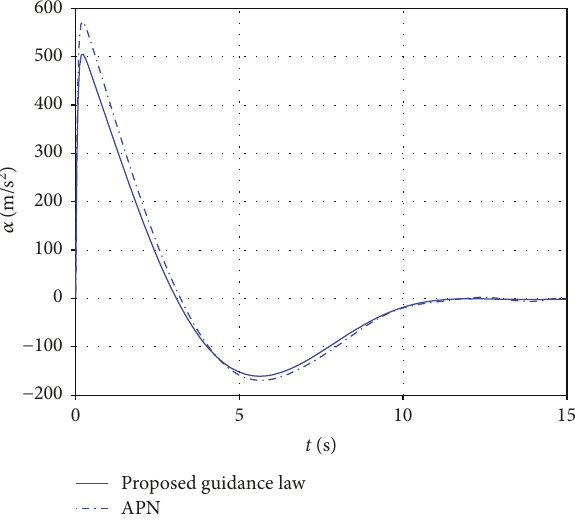
Figure 5: The variation of LOS angle rotation rate.